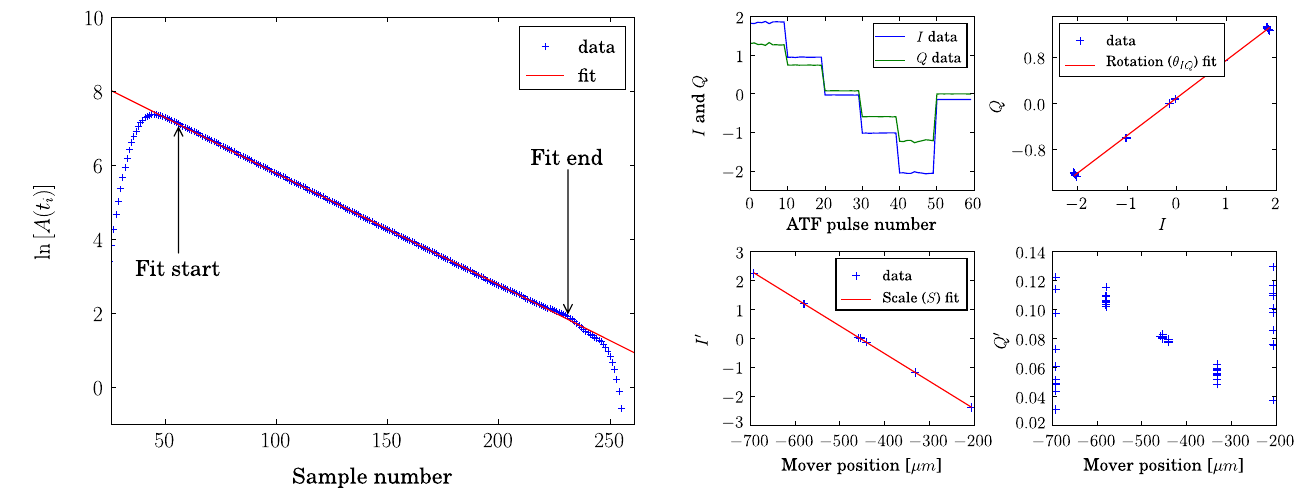
FIG. 12. A typical mover calibration: I and Q values vs pulse number taken during the calibration (top left), Q vs I averaged for each step and fitted with a straight line to extract the rotation angle (top right), rotated I vs mover position averaged for each step and fitted to a straight line to extract the position scale (bottom left), and rotated Q vs mover position serving as an error estimate (bottom